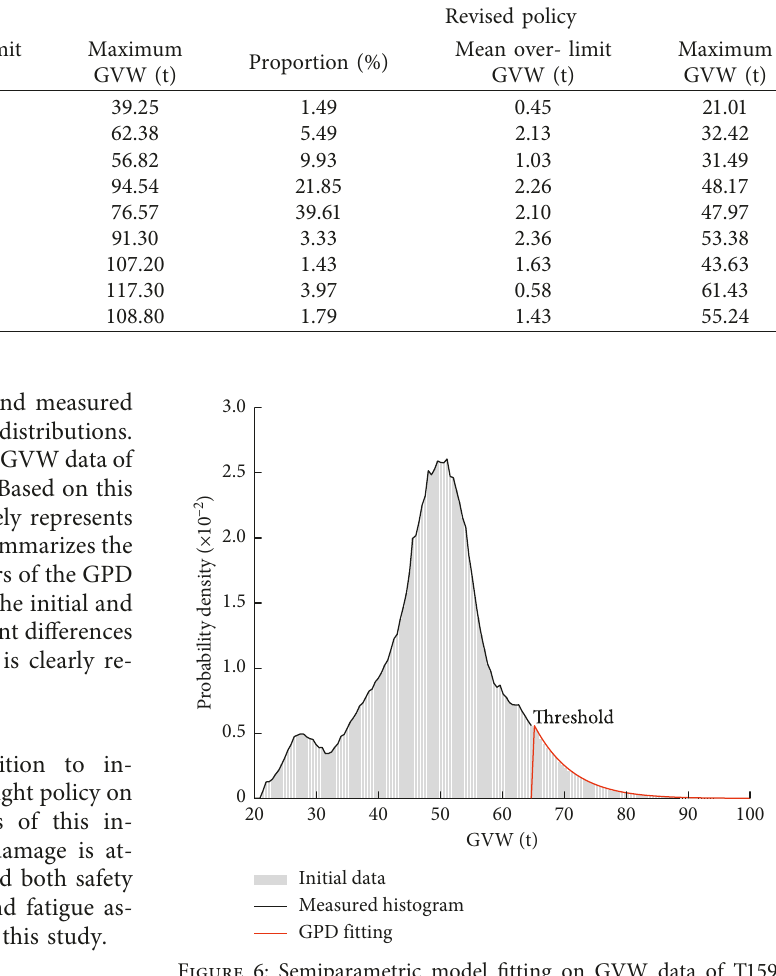
Figure 6: Semiparametric model fitting on GVW data of T159 under the revised toll-by-weight